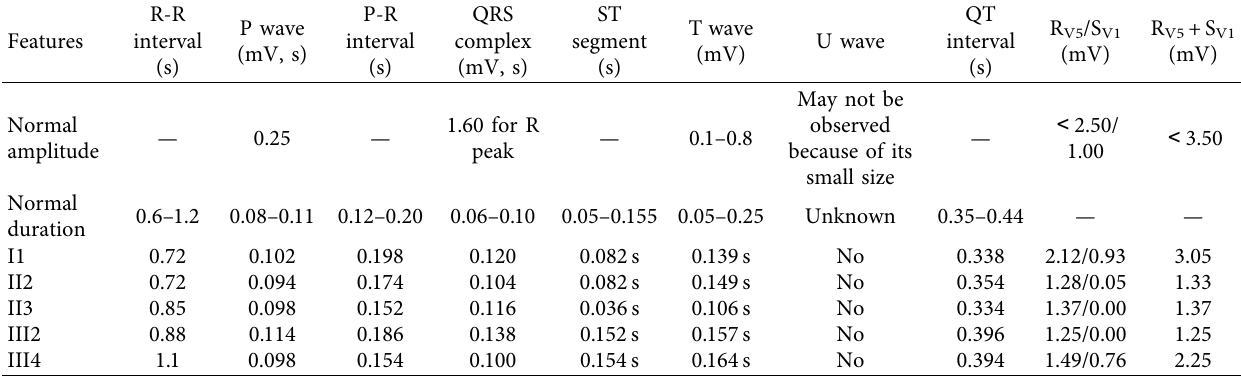
Figure 2: (a) Routine ECG manifestations of I1: sinus rhythm; complete right bundle branch block (RBBB); STsegment elevation (V1, V2), Brugada-like changes; (b) routine ECG manifestations of II2: sinus rhythm; brugada wave; (c) routine ECG manifestations of II3: sinus rhythm; the V1 and V2 leads showed Brugada wave-like changes; (d) routine ECG manifestations of III 2: sinus rhythm; the V1 and V2 leads showed Brugada wave-like changes; (e) routine ECG manifestations of III4: sinus bradycardia; incomplete RBBB? brugada syndrome? ST segment elevation (II, III, and aVF). Table 2: ECG characteristics of five patients with Brugada